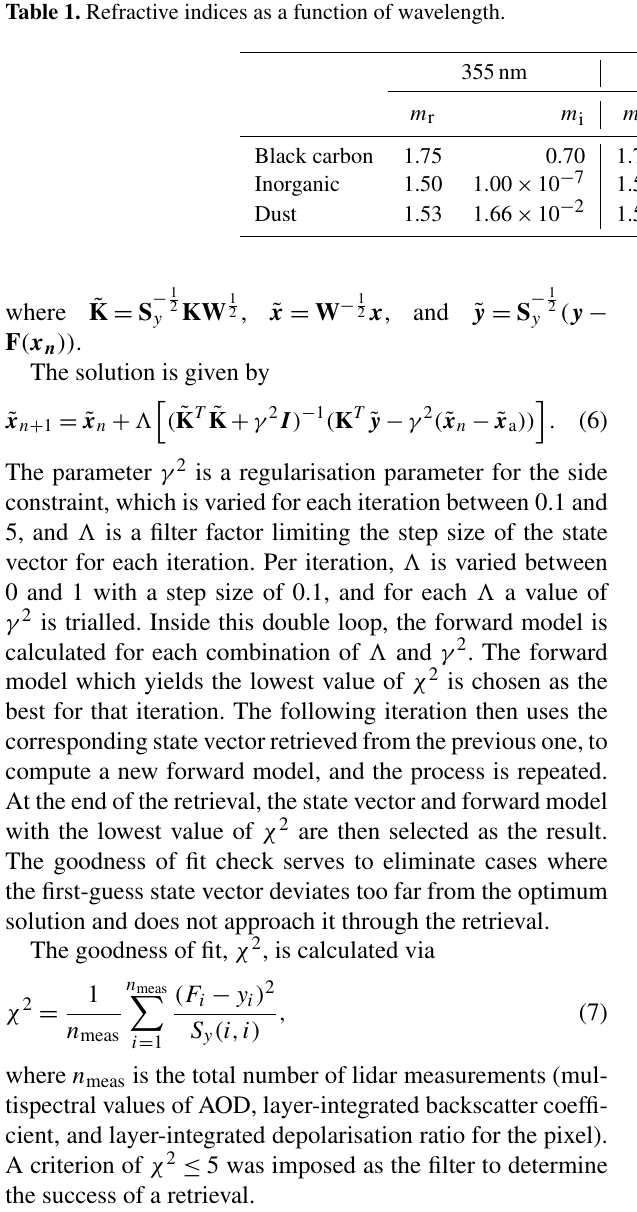
Table 1. Refractive indices as a function of wavelength.